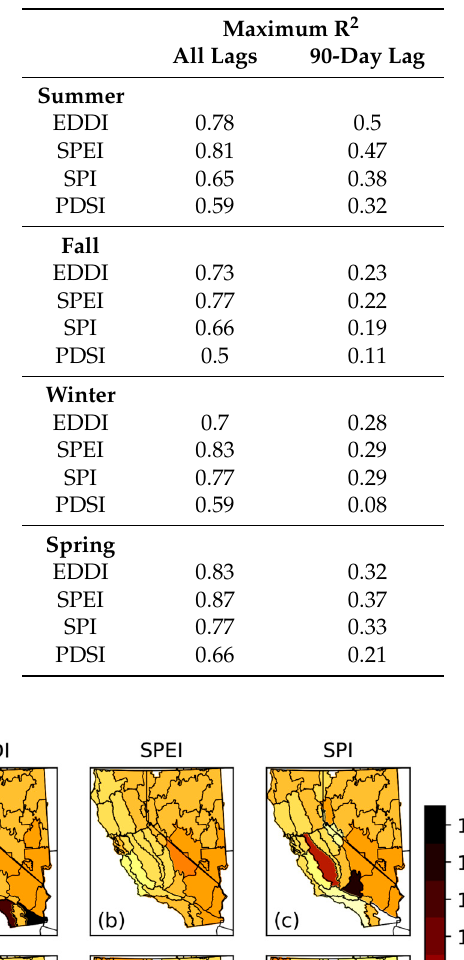
Table 1. California–Nevada domain-average maximum R 2 between seasonally averaged fm-1000 and drought indices.